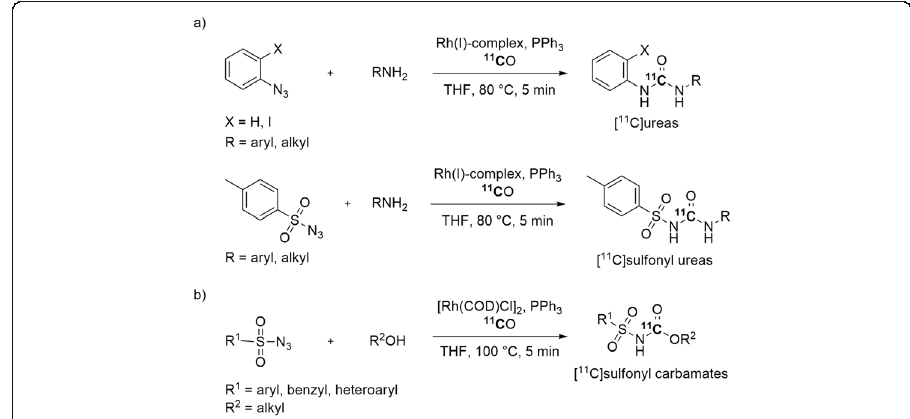
Fig. 17 Rh(I)-Mediated 11 C-carbonylations producing: a [ 11 C]ureas and [ 11 C]sulfonyl ureas; b [ 11 C]sulfonyl carbamates. [Rh(COD)Cl] 2 =chloro(1,5-cyclooctadiene)rhodium(I)